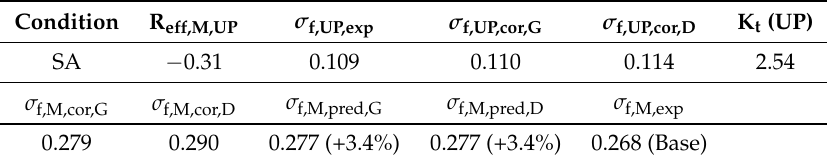
Table 11. Fatigue strength assessment of the SA